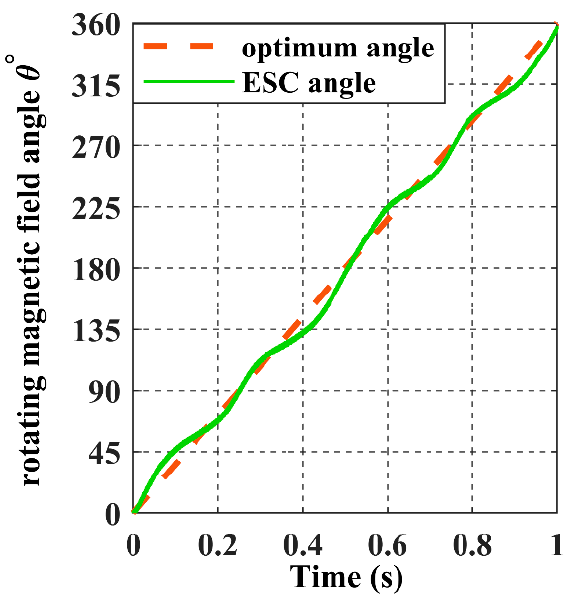
Figure 22. The rotating magnetic field angle θ in the closed-loop when the receiver moves according to the 8-shaped trajectory 𝝘 .